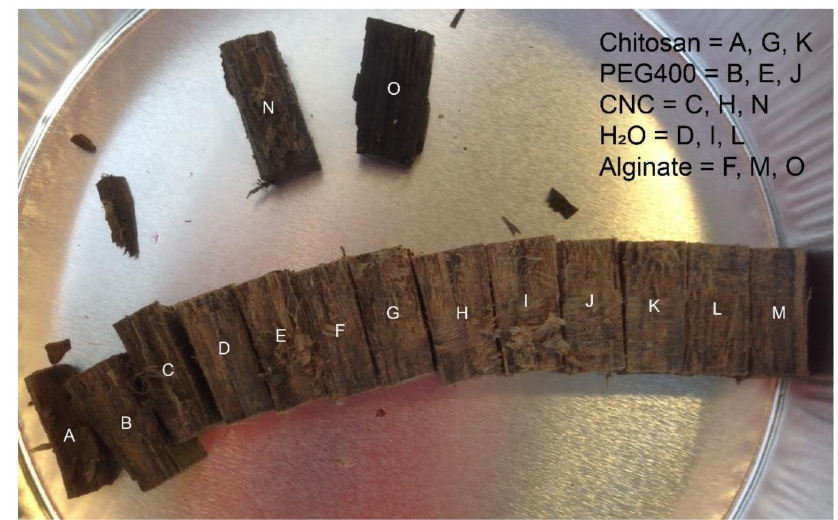
Figure A2. Visual observation of samples of archaeological wood before